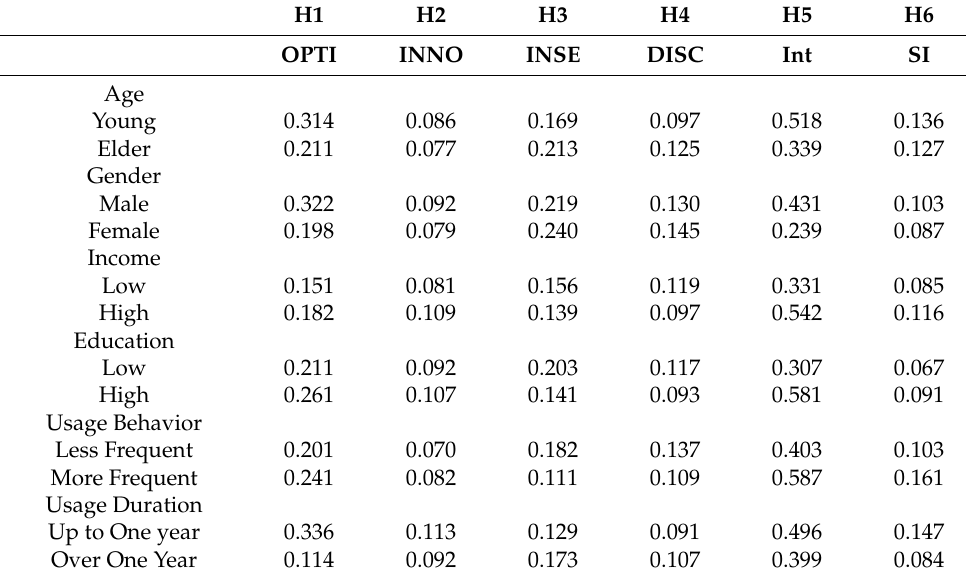
Table 5. Analysis of Multigroup